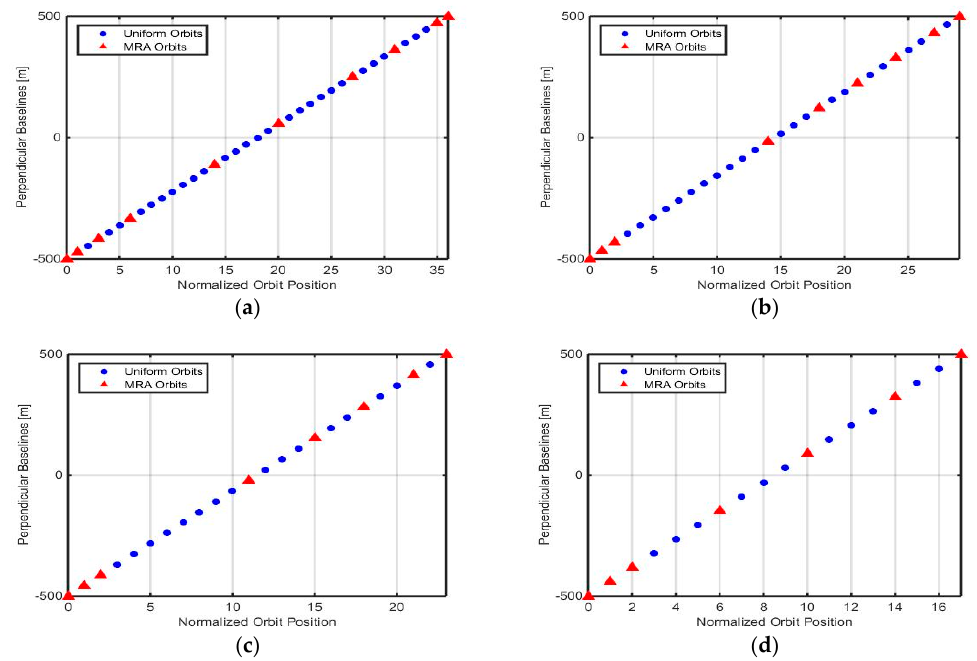
Figure 3. The simulated uniform orbits and their corresponding MRA orbits: ( a ) 10 MRA out of 37 uniform orbits; ( b ) 9 MRA out of 30 uniform orbits; ( c ) 8 MRA out of 24 uniform orbits; ( d ) 7 MRA out of 18 uniform orbits.